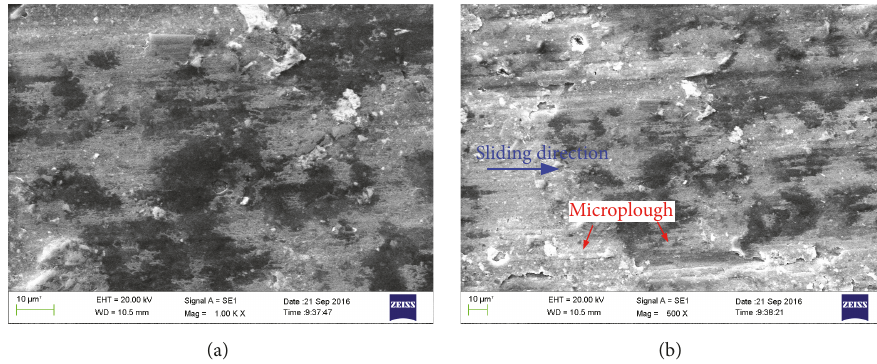
Figure 6: The worn surface topography of composites specimen for the test of 30 ∘ C ∼ 100 ∘ C: (a) 1000x and (b)